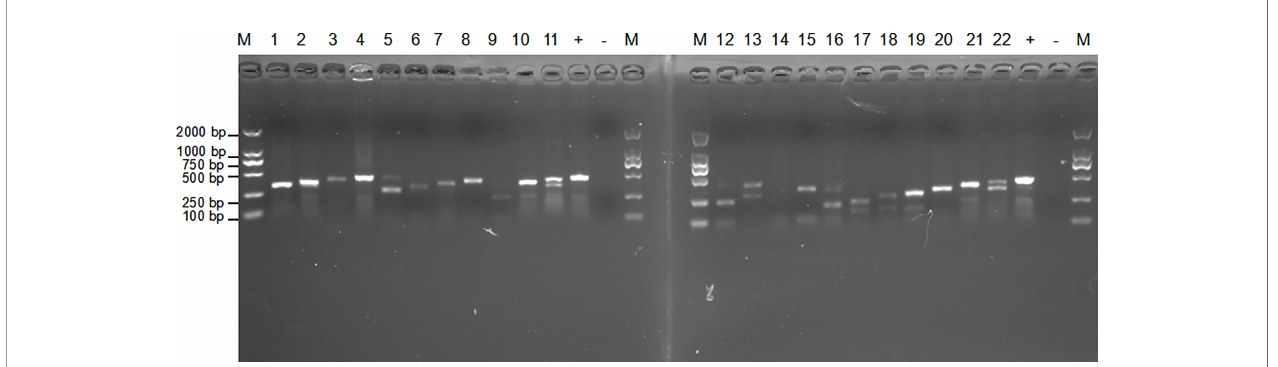
FIGURE 2 | Primer screening for basic RPA. A total of 16 pairs of speci fi c primers targeting the orf2 gene of B . pseudomallei type III secretion system (T3SS) cluster genes were designed for screening by basic RPA (2 ng gDNA as template, at 40°C for 15 min). Lanes 1-16 are primers F1/R4, F1/R3, F1/R2, F1/R1, F2/R4, F2/R3, F2/R2, F2/R1, F3/R4, F3/R3, F3/R2, F3/R1, F4/R4, F4/R3, F4/R2, and F4/R1. Lanes 17-22 are the results of repeated electrophoresis of some sets of primers. Lane + is the positive control. Lane - is the negative control. M: